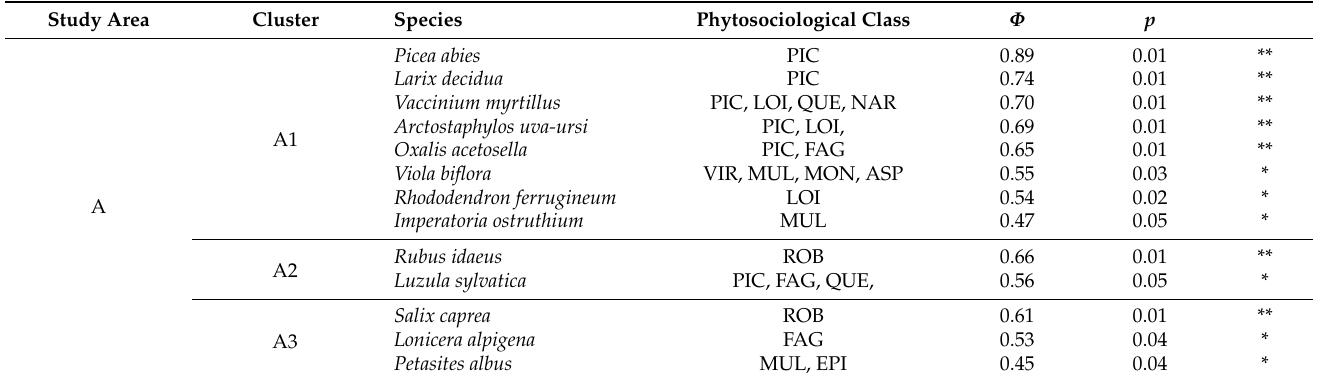
Figure 4. Dendrogram of the relevés of study area A ( a ), distribution of total within-clusters sum of squares by number of relevé groups distinguished via hierarchical clustering ( b ), and photographs of the three vegetation types ( c ). Key: A1, Picea abies forest; A2, Rubetum idaei ; A3, Piceo abietis-Sorbetum aucupariae . Table 1. Diagnostic species of each plant community (cluster). The codes of the clusters are the same ones used in the dendrograms. Phytosociological class code, Pearson’s phi coefficient ( Φ ), and p -value of each diagnostic species are reported. The codes of phytosociological class are the same used in [36]: PIC, Vaccinio-Piceetea ; LOI, Loiseleurio procumbentis-Vaccinietea ; QUE, Quercetea robori-petraeae ; NAR, Nardetea strictae ; FAG, Carpino-Fagetea sylvaticae ; VIR, Betulo carpaticae-Alnetea viridis ; MUL, Mulgedio-Aconitetea ; ASP, Asplenietea trichomanis ; MON, Montio-Cardaminetea ; ROB, Robinietea ; EPI, Epilobietea angustifolii ; RHA, Crataego-Prunetea ; ERI, Erico-Pinetea ; FES, Festuco-Brometea ; MOL, Molinio-Arrhenatheretea ; ART, Artemisietea vulgaris ; GER, Trifolio-Geranietea sanguinei . Key: *, significant ( p < 0.05); **, significant ( p < 0.01).